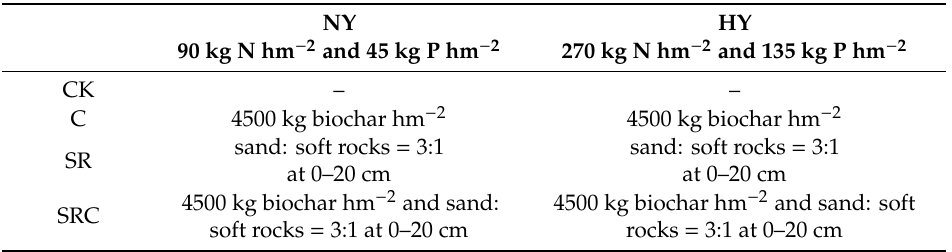
Table 1. The experiment design in this study.